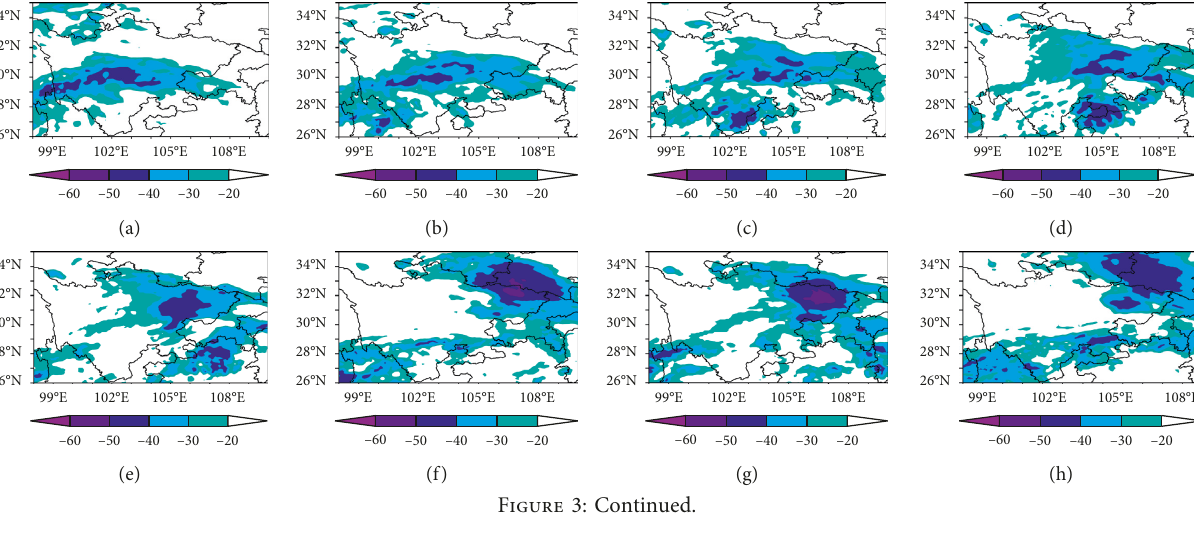
Figure 2: 500hPa geopotential height (gpdam) and wind fields (red, m distribution (shaded, ° C) at (a) 1200 UTC 26 October 2014, (b) 0000 UTC 27 October 2014, (c) 1200 UTC 27 October 2014, and (d)